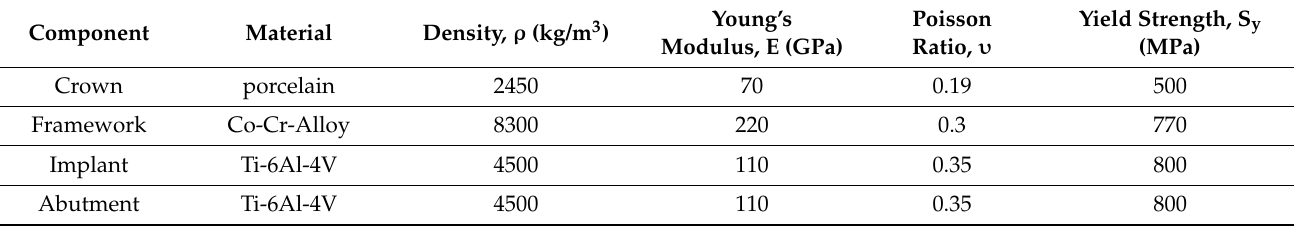
Table 1. Mechanical properties and materials of the implant [14].